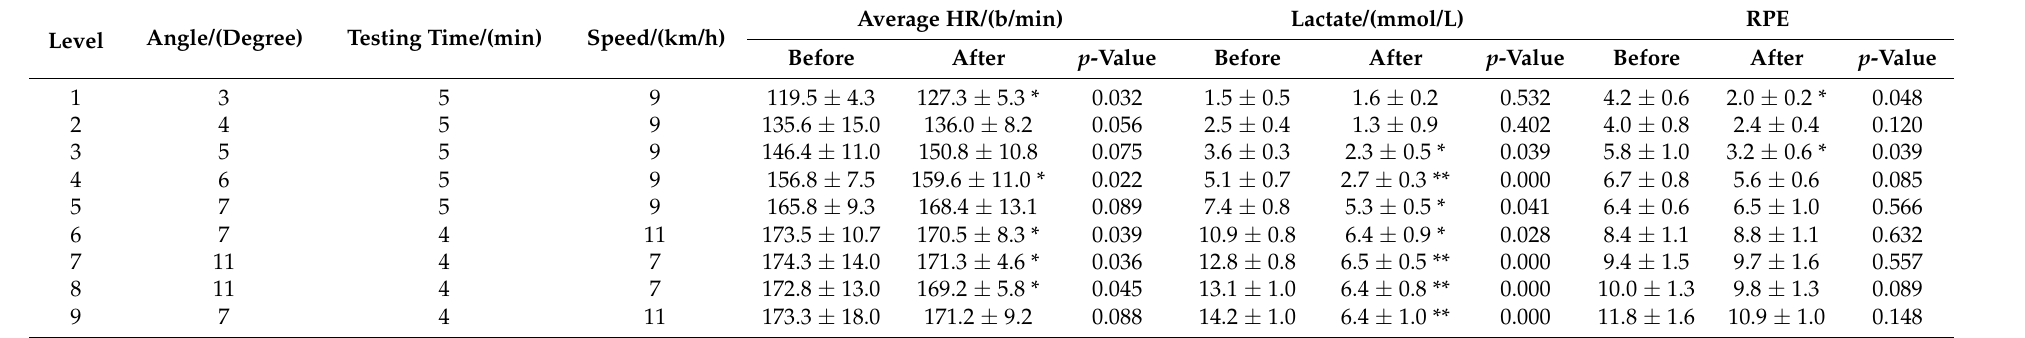
Table 7. Indicators related to the specific athletic ability of male athletes.